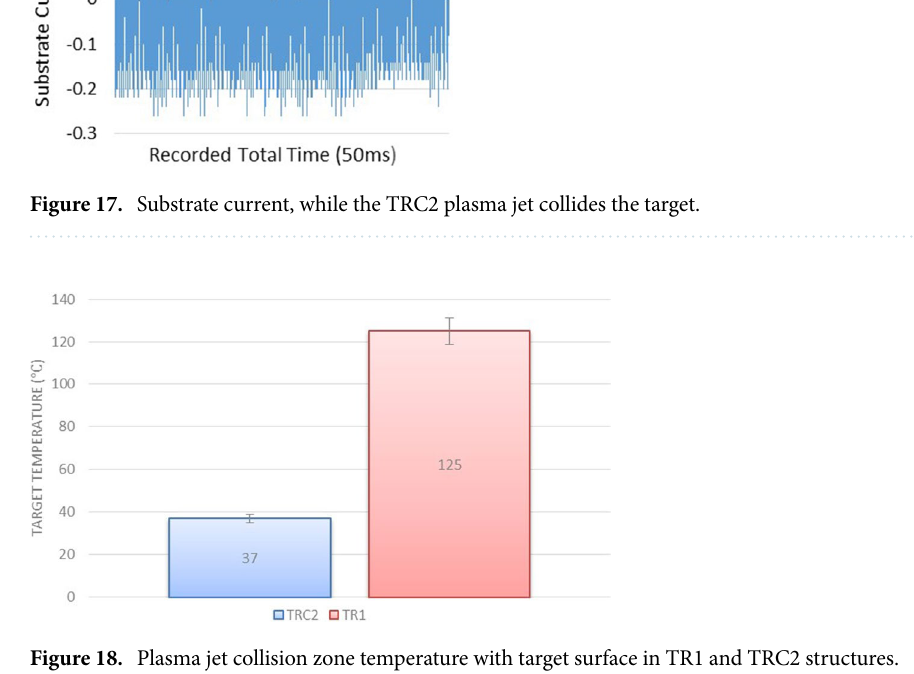
Figure 18. Plasma jet collision zone temperature with target surface in TR1 and TRC2